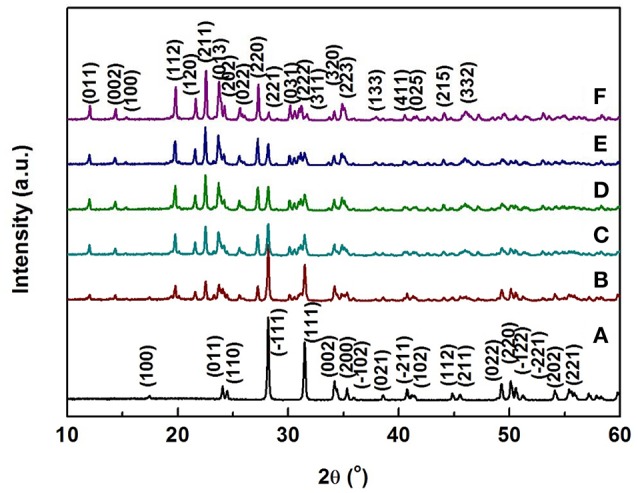
XRD patterns of ZrO2, Zr2WP2O12, and Zr2WP2O12-ZrO2 composites with different mass ratios sintered at 1,200°C for 6 h. (A) ZrO2, (B) 1:1 Zr2WP2O12:ZrO2, (C) 2:1 Zr2WP2O12:ZrO2, (D) 3:1 Zr2WP2O12:ZrO2, (E) 4:1 Zr2WP2O12-ZrO2, (F) Zr2WP2O12.